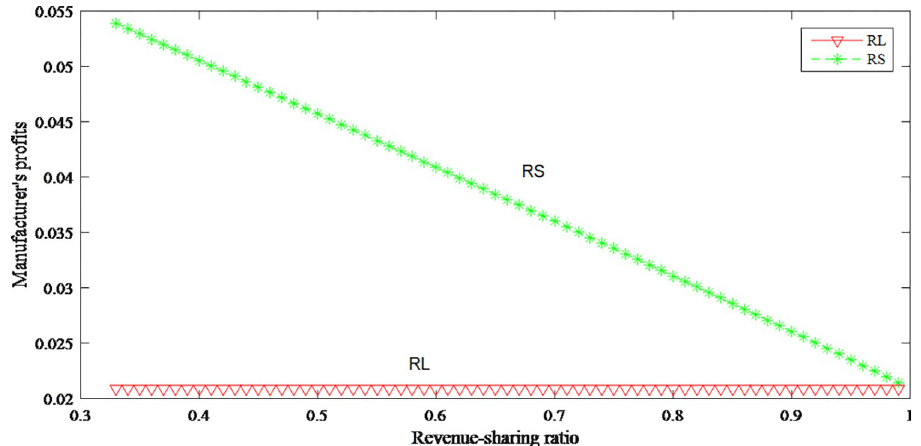
Fig 27. The impact of revenue-sharing contract on the manufacturer’s profits.